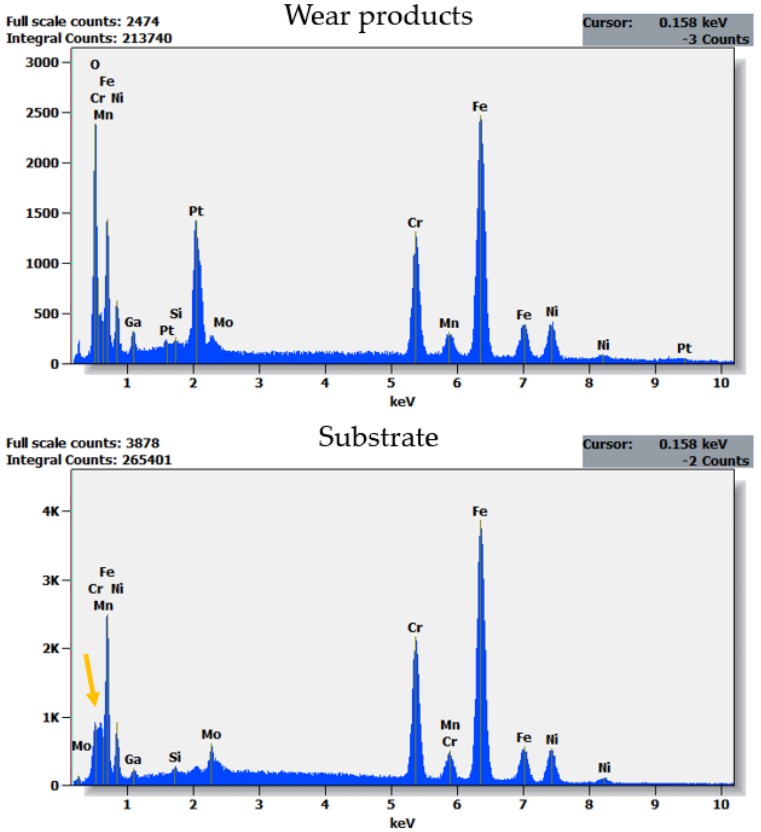
Figure 9. EDX spectra collected for a cross-section of the wear track obtained on the uncoated 316L stainless steel. The cross-section was obtained with the use of FIB. Therefore, Ga and Pt can be present in spectra. Note the oxygen lacking in spectra obtained for the substrate material (yellow arrow).